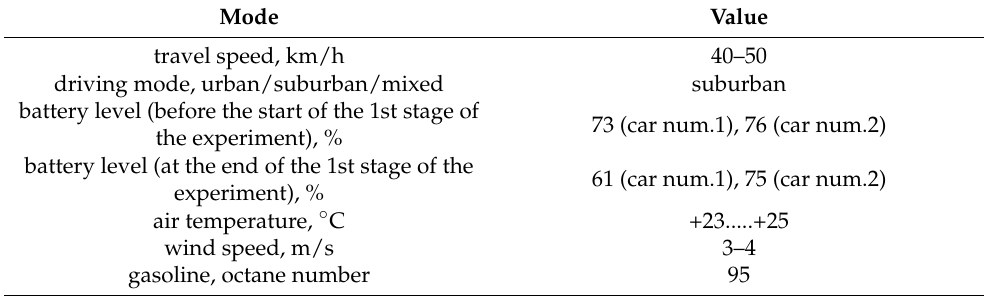
Table 3. Actual modes of the experiment.